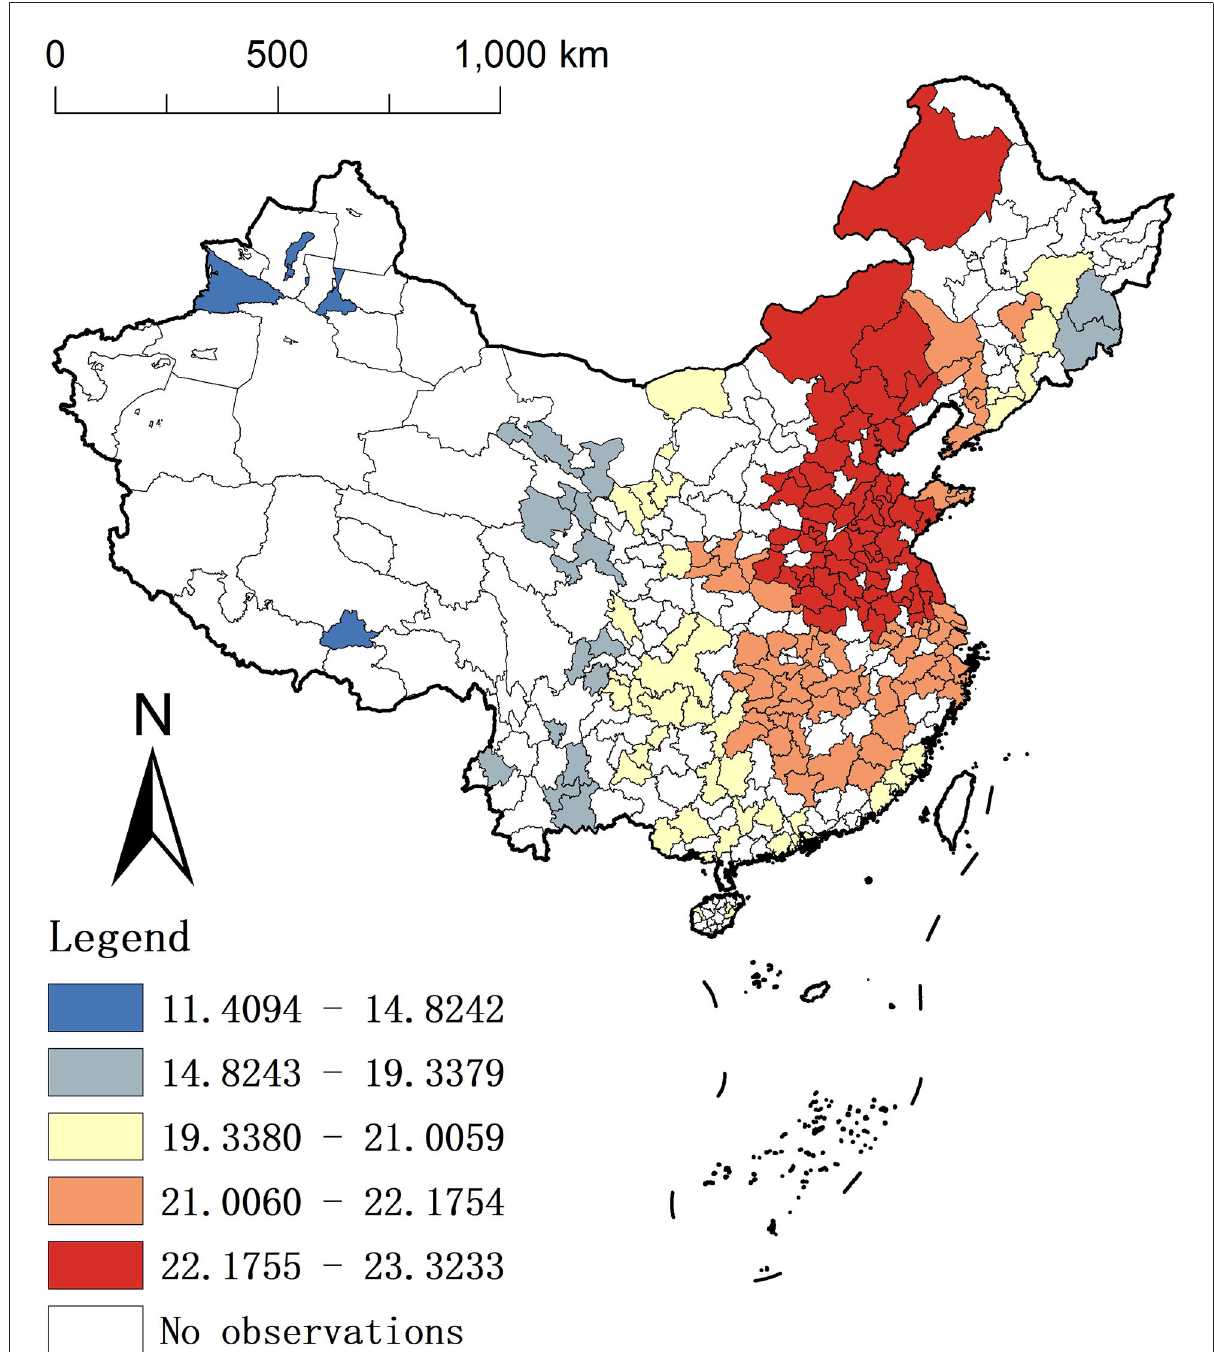
FIGURE3 Spatial distribution of the average coefficients for